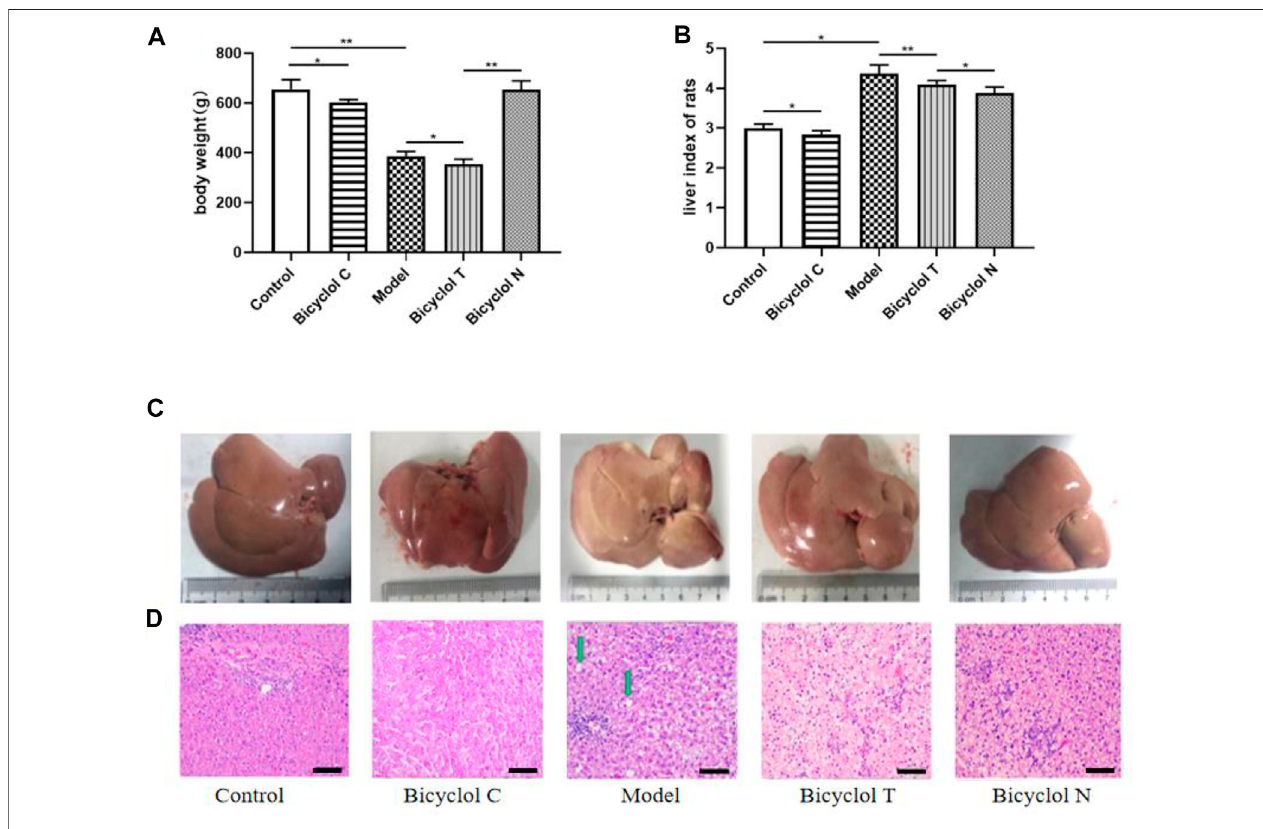
FIGURE2| Effectofbicyclolonthebodyweight,volumeofliverandhistopathologicalexaminationinT2DM – NAFLDrat. (A) Bodyweight. (B) Liverindexofrats. (C) Appearance of the liver. (D) Hematoxylin and eosin staining: lipid droplets (green arrow) in livers. Data are presented as means ± SD. * p < 0.05. ** p < 0.01.